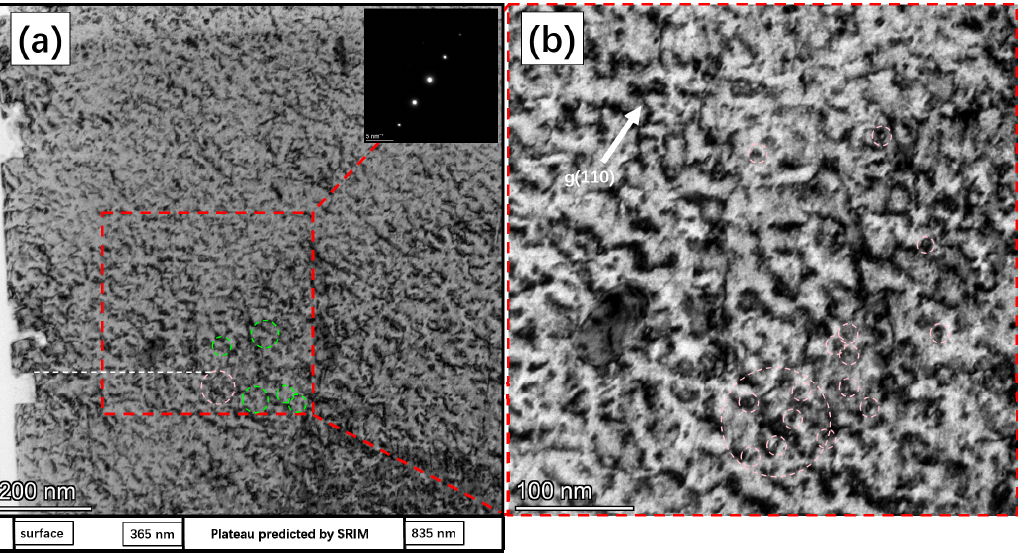
Figure 4. TEM bright field (BF) ( a ) and magnified image ( b ) of RPV steel at plateau damage level of 1.5 dpa predicted by SRIM. The BF images were taken under two-beam BF conditions using a diffraction vector of g = (110) near the [001] zone axis. The pink circle indicates that the dislocation loops are visible at g = (110), and the green circle indicates that the dislocation loops are visible at g = (020). The white dashed line is used to highlight the same position under different g vector.